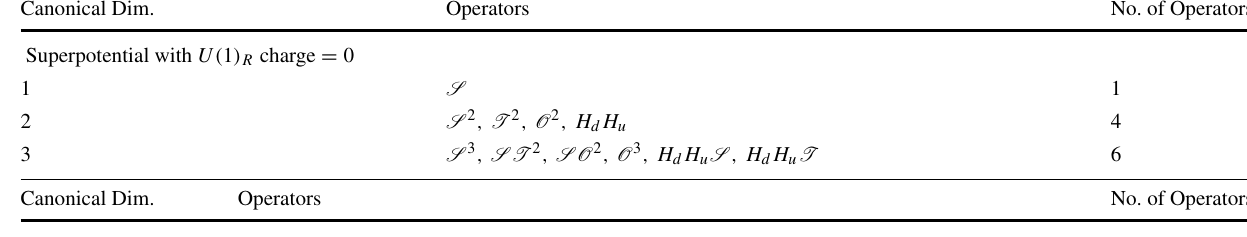
Table 29 MSSM + Global U ( 1 ) R : Superpotential terms (for N f = 1). Terms in red correspond to the operators given in [107] Canonical Dim.